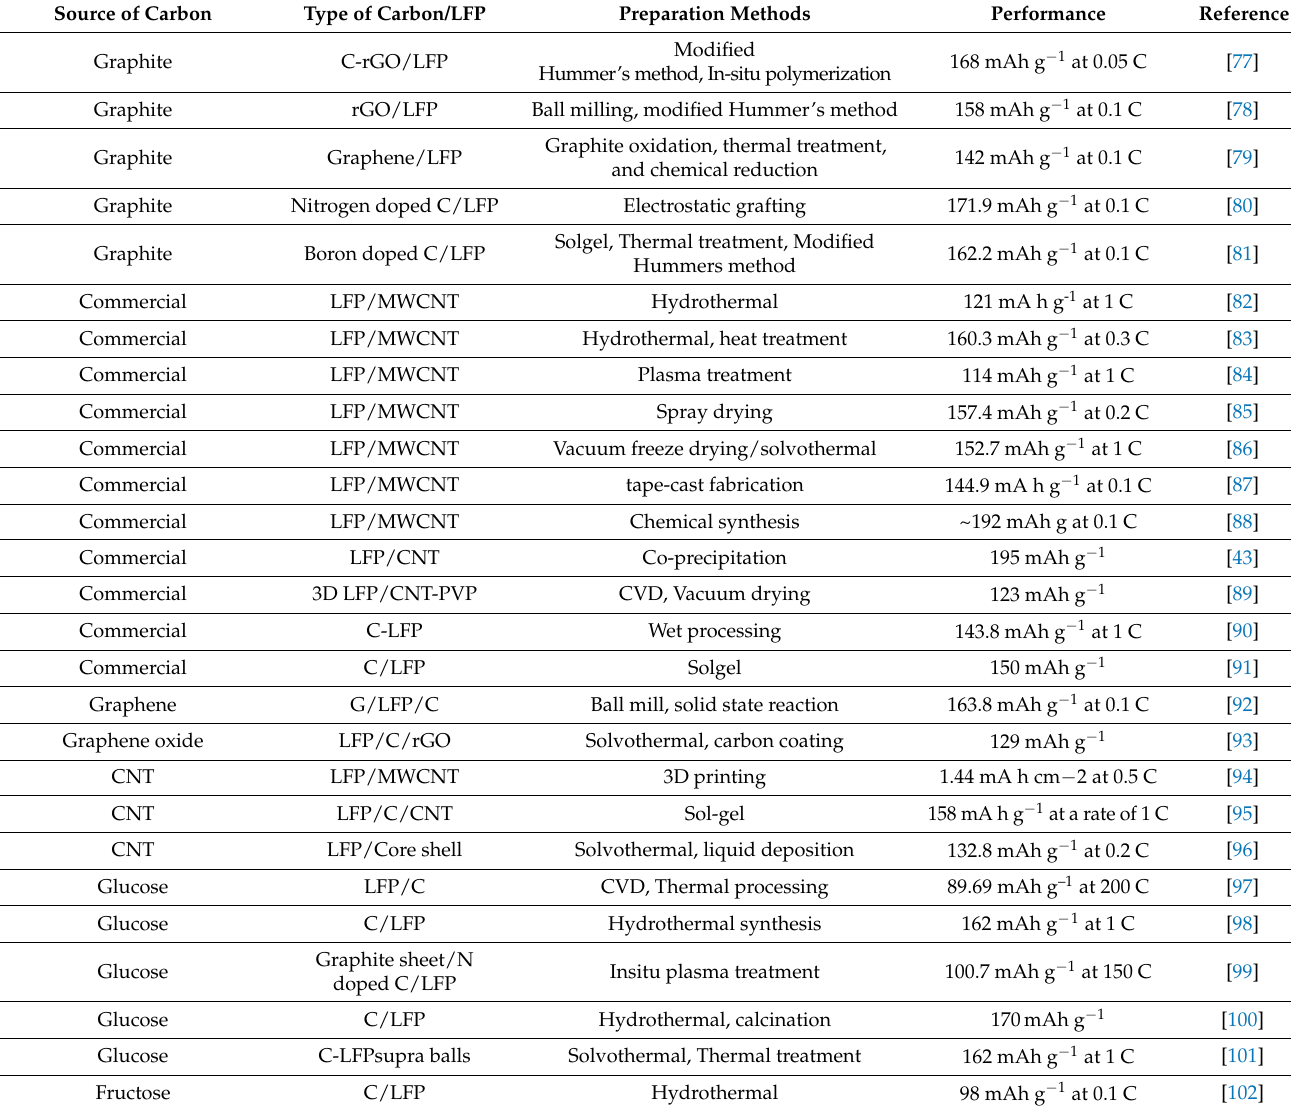
Table 2. Preparation methods and performance of C-LFP cathodes in